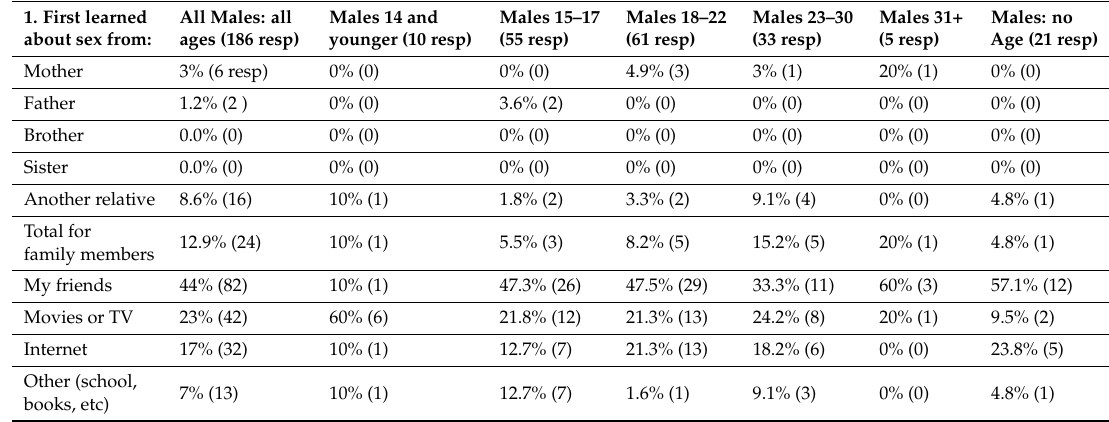
Table 1. First Learned About Sex—All Males.